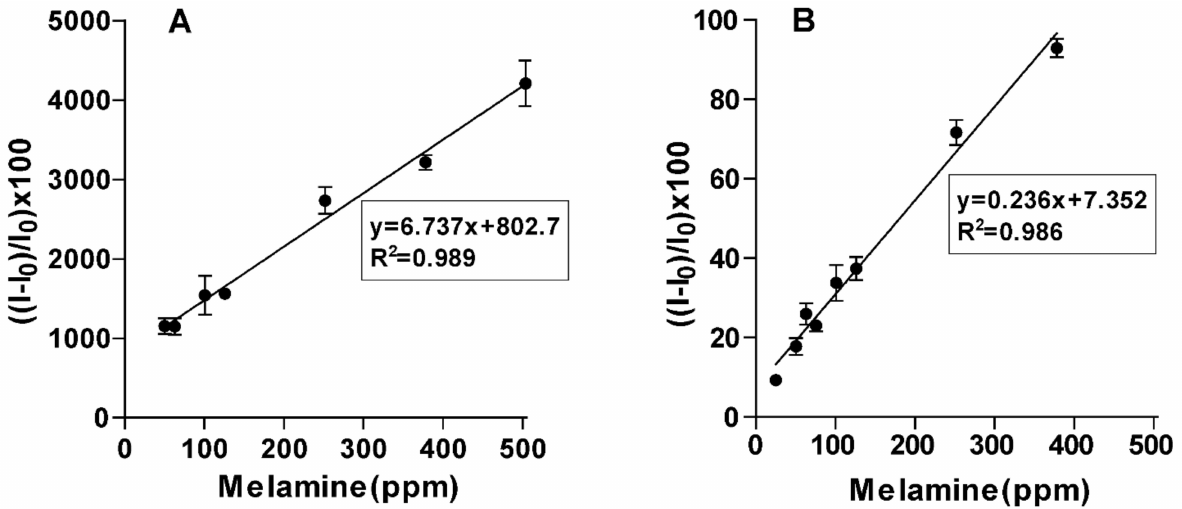
Figure 5. Effect of melamine concentration in ( A ) distilled water and ( B ) milk aqueous system on the fluorescence intensity of CB-CA solution ( λ em = 520 nm, λ ex = 490 nm). For the microplate experiment, ‘I’ represents the emission intensity (au) obtained from well solutions having different melamine levels and I 0 corresponds to the emission intensity of wells that are free of melamine. The error bars indicate the standard deviation values from triplicate readings for the three different sets of experiments.